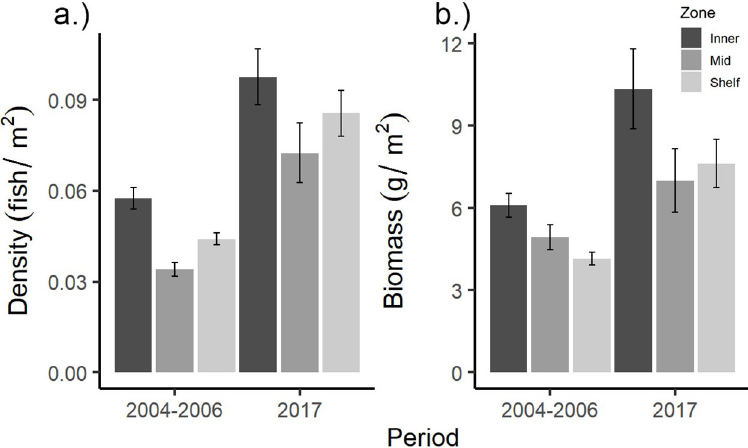
Fig 7. Total density and biomass trends in the LPNR. Commercial species mean density (fish/m 2 ) (a), and biomass (g/m 2 ) (b) from the LPNR by sampling period (2004–2006, 2017) and cross-shelf zone with standard error margins indicated. Level of significance for period-wise comparisons: � p < 0.05; �� p < 0.01; ��� p <